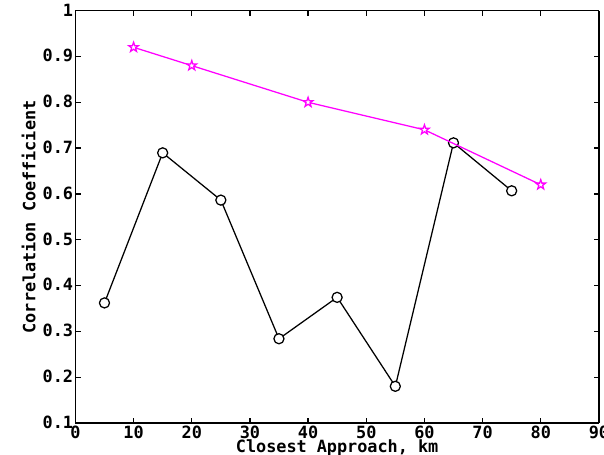
Fig. 1. Average AERONET and CALIPSO aerosol optical depths at the 0.532µm wavelength as a function of the CALIPSO closest ap- proach, centered on 10-km wide bins. Upper abscissa indicates the corresponding number of overpasses, and errorbars indicate ± one standard deviation of the mean. Note that the greatest divergence of the optical depths does not occur at the greatest overpass distances, indicating that the difference between the datasets is not dominated by spatial heterogeneity of the aerosol fields.